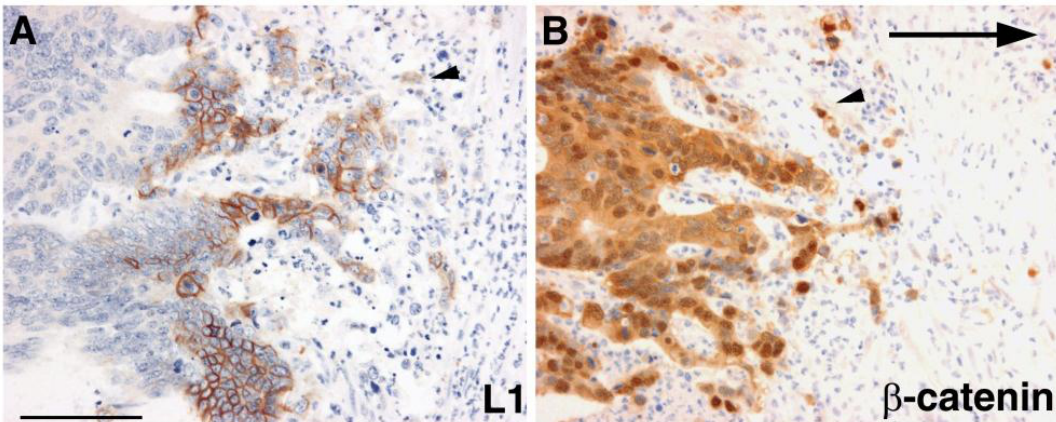
Figure 1. L1 is expressed in colorectal cancer (CRC) cells at the invasive edge of the tumor tissue in cells expressing nuclear β-catenin. (A) CRC tissue immunostaining for L1; (B) A serial section of the same area immunostained for β-catenin. Note the membranal staining with L1 antibody while β-catenin is stained both in the cytoplasm and in the nuclei of cells indicative of active Wnt signaling. The large arrow points to the direction of invasion. The small arrowheads point to a single invading CRC cell expressing L1 and nuclear β-catenin (from reference 30). The bar represents 75 m.